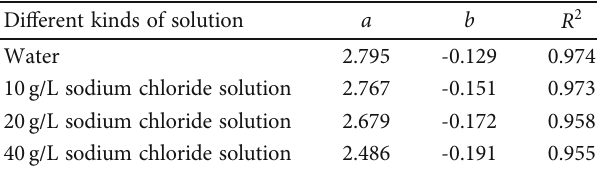
Table 4: Sample fi tting